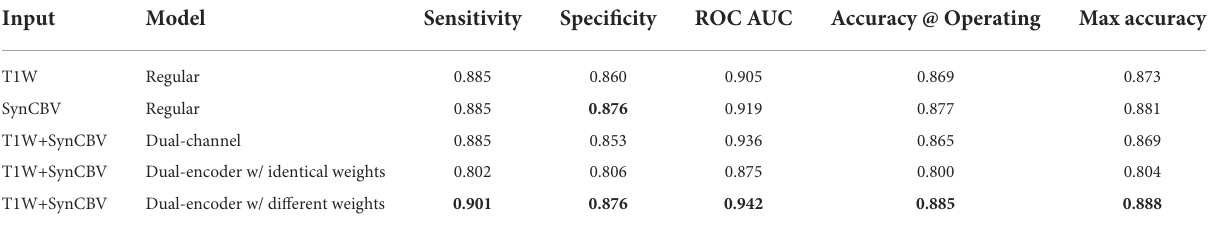
TABLE 2 Performances of the five variants of the AD-classification